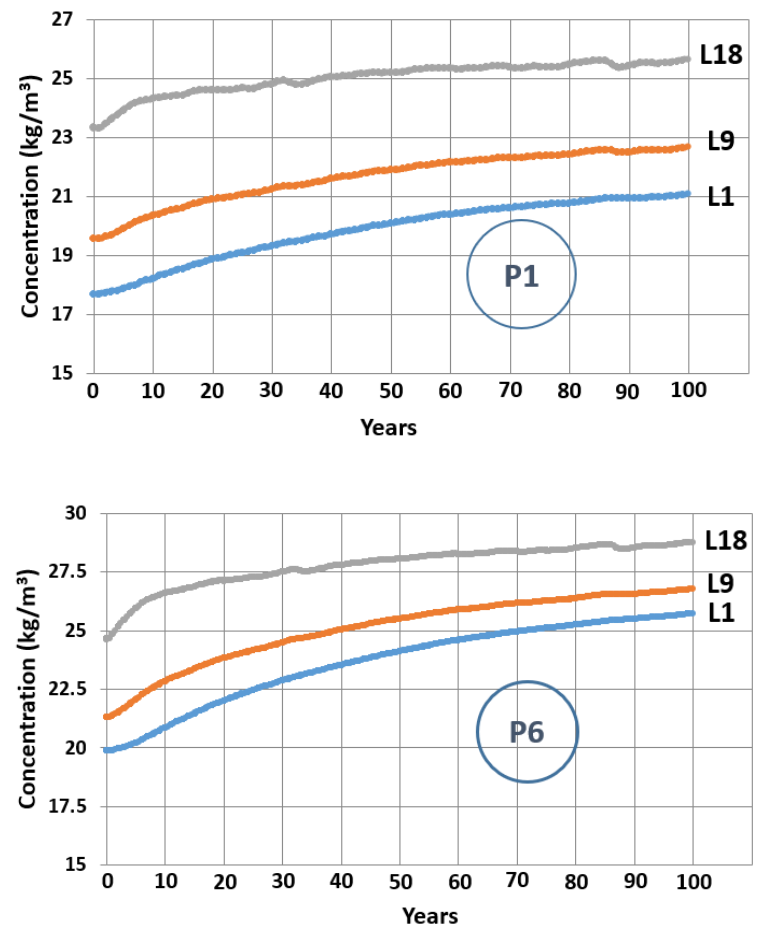
Figure 12. Concentrations variation at monitoring piezometers P1 and P6 (100 m from the coast) under RCP scenario 2.6. L1: layer 1; L9: layer 9; L18: layer 18.